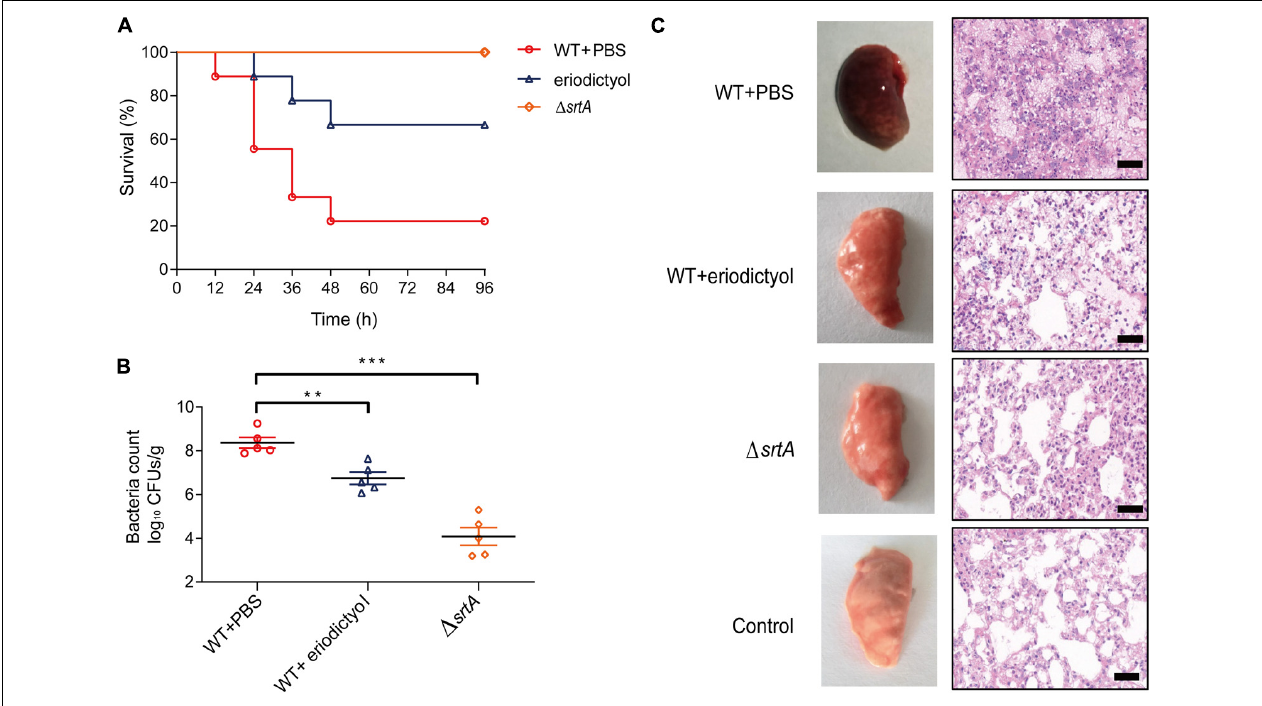
FIGURE 6 | Eriodictyol protects the mice from S. aureus -induced pneumonia. (A) Effect of eriodictyol treatment on the survival of mice ( n = 10) infected with a lethal dose of S. aureus . Mock vs. eriodictyol, ** P < 0.01; log-rank test. (B) Effect of eriodictyol treatment (100 mg/kg) on the bacterial load in the lungs of mice ( n = 5). ** P < 0.01, *** P < 0.001 vs. the WT group; Mann-Whitney test, two-tailed. Horizontal bars represent the mean values. (C) Histopathology of the lung (H&E staining) of mice treated with or without eriodictyol (100 mg/kg/d). The animal data were obtained in two separate experiments (magnification: 400 × ; scale bar, 50 µ